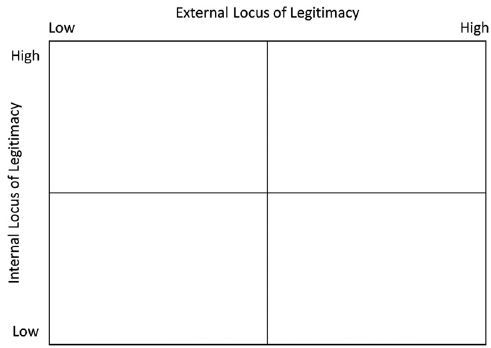
Figure 1. Locus of